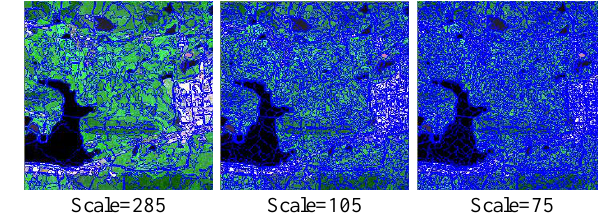
Figure 3 Segmentation